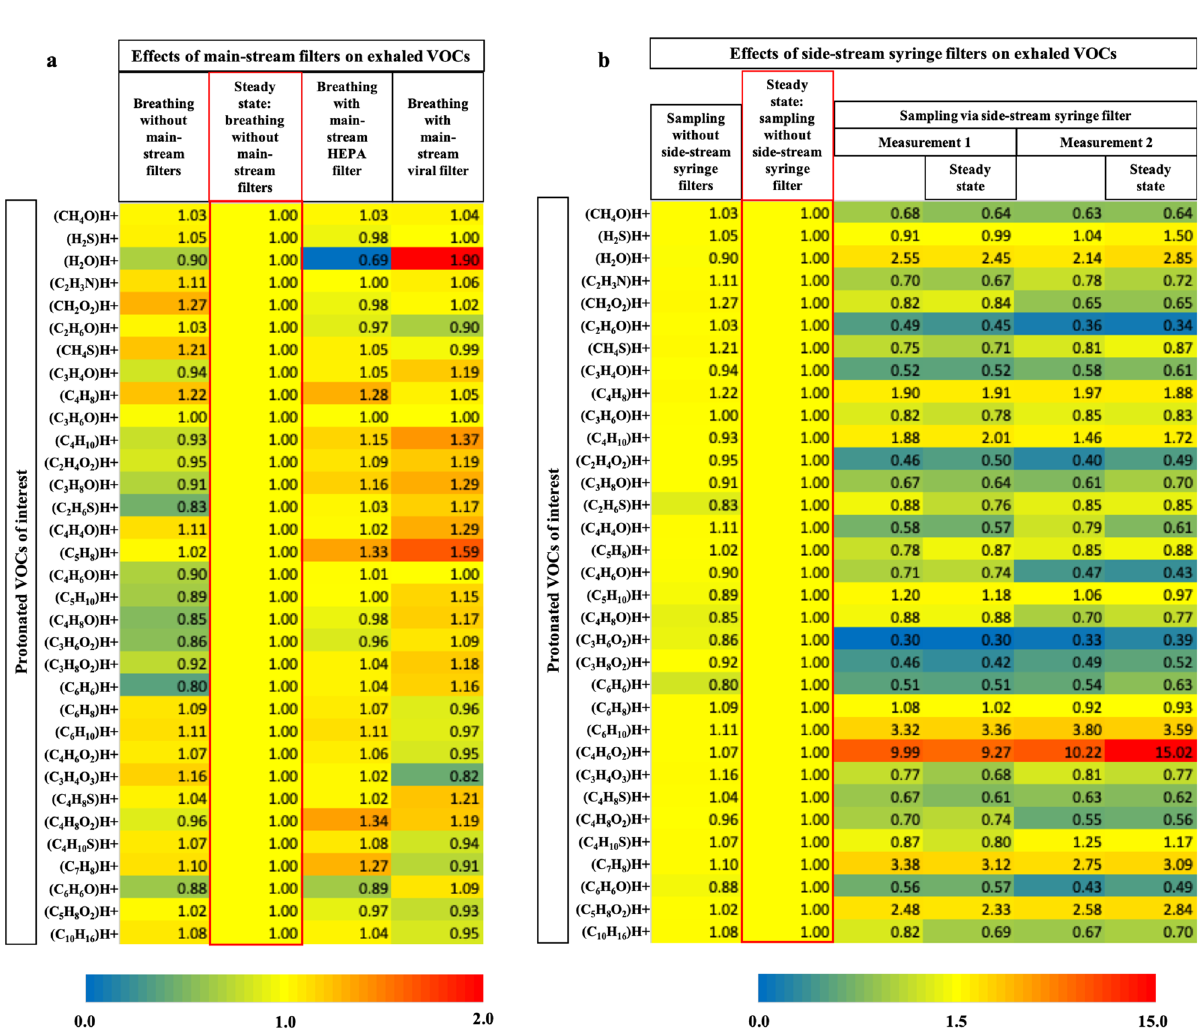
Figure 1. Relative differences in exhaled VOCs concentrations (mean over two min) without and with the mainstream ( a ) and side-stream ( b ) viral filters. All Y-axis represent protonated VOCs of interest. All X-axis represent experimental conditions. VOCs data were normalised onto the corresponding values from sampling at the steady state of breathing without filters that are placed within red-coloured margins. The steady states are the actual comparison points for physiological and/or analytical effects induced by the filters. Changes in colour represents relative differences in concentrations. Red and blue colour represents relatively high and low values, respectively. ( a ) Mainstream filters depict both physiological and analytical effects. ( b ) Side-stream filters depict only analytical effects and repeated measurements (1 and 2) are presented to demonstrate